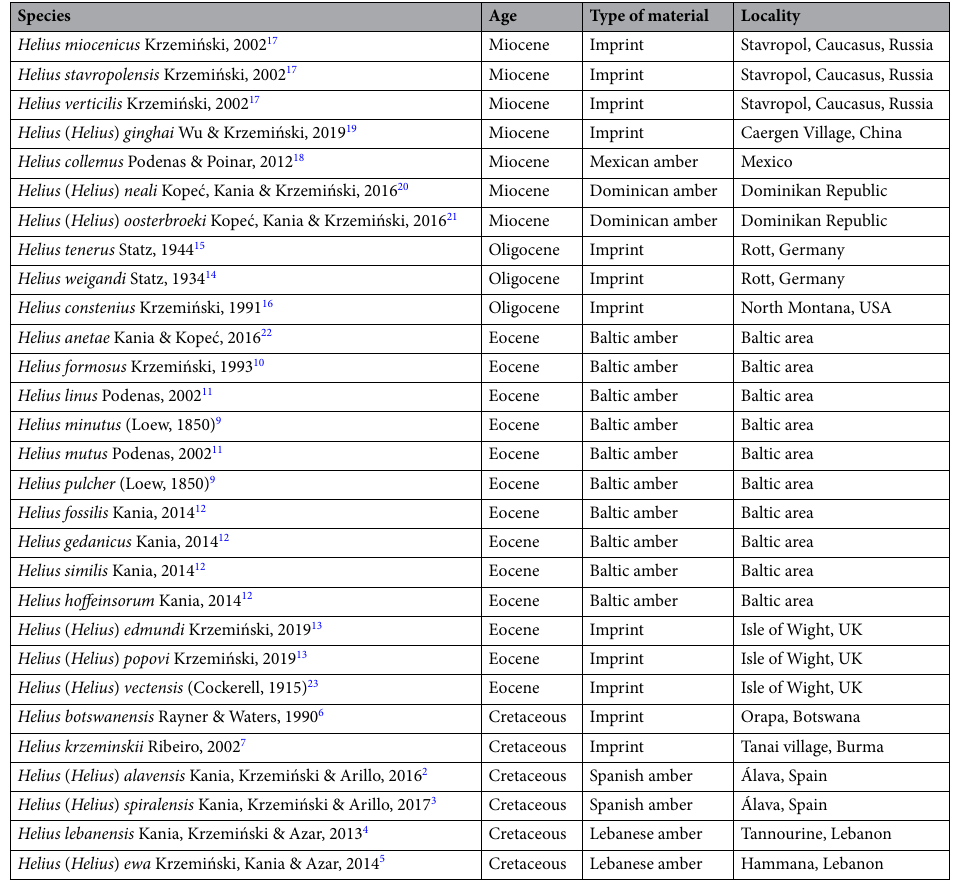
Table 1. List of all fossil species belonging to genus Helius , with age and